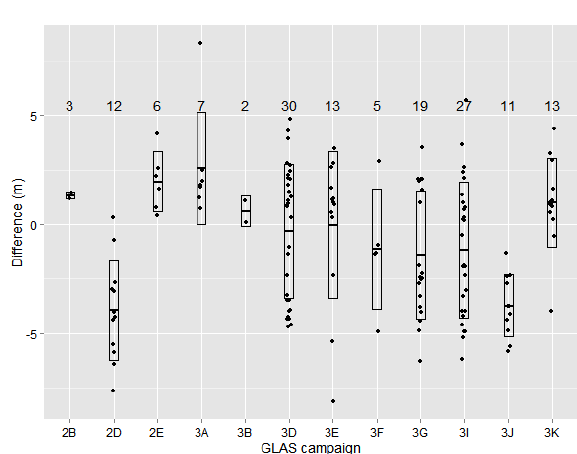
Figure 7. Differences of ICESat/GLAS heights to UAV based heights at footprint geolocation for each GLAS campaign with averaged difference and standard deviation, represented by the box plot. Numbers of observations are written above each